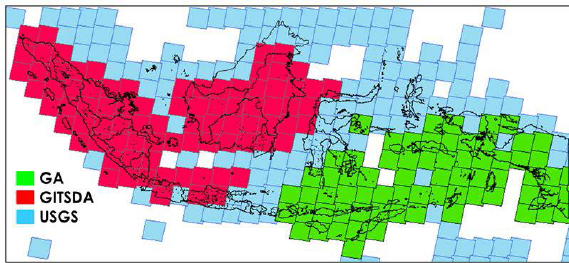
Figure 1. Indicative extent of spatial coverage of the GISTDA, GA and USGS Landsat